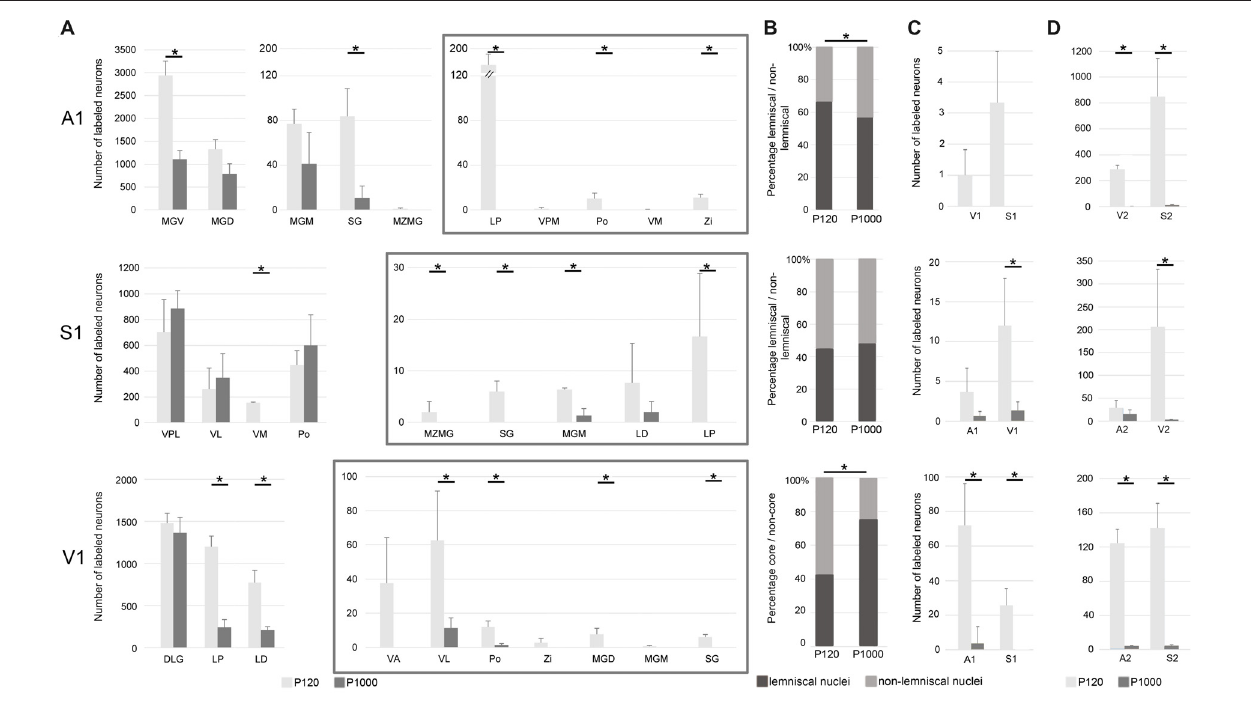
eliminated, such as in the marginal zone of the MGB